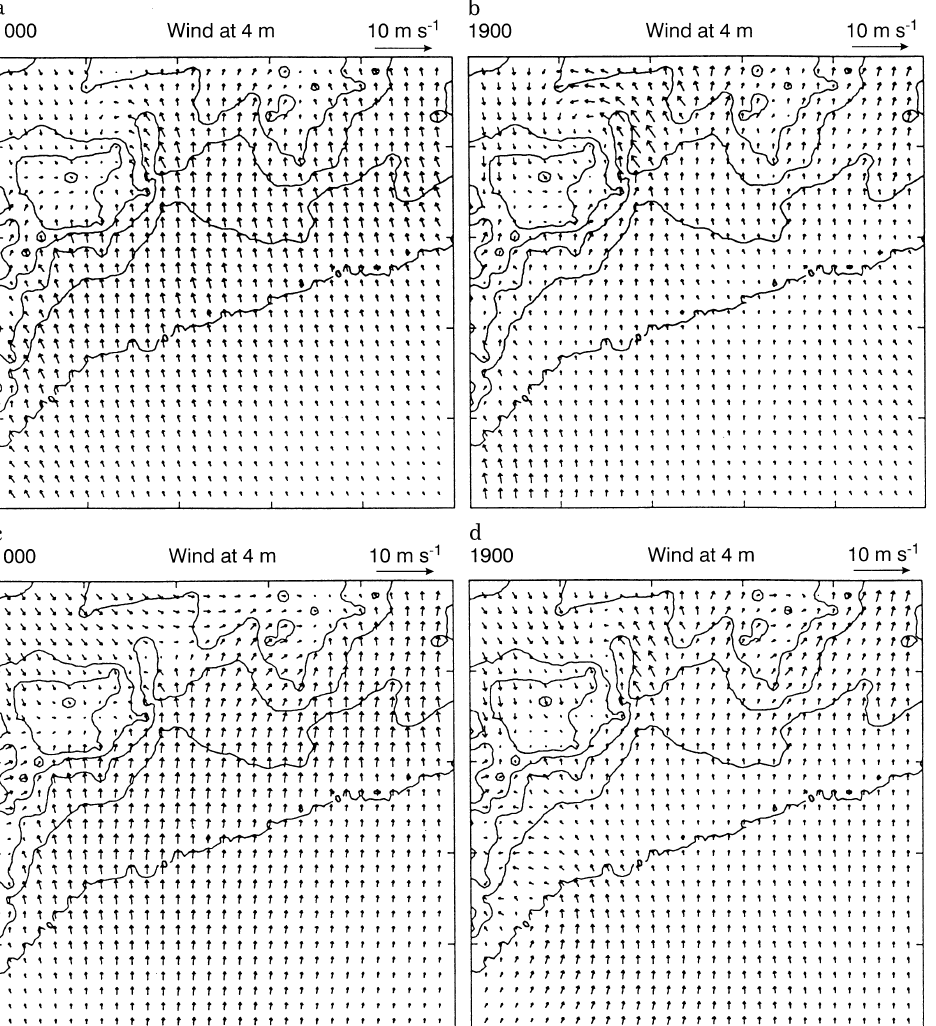
Fig. 6a–d. Horizontal velocity at 4 m level in m/s at a 1000 LST, E1; b 1900 LST, E1; c 1000 LST, E2; d 1900